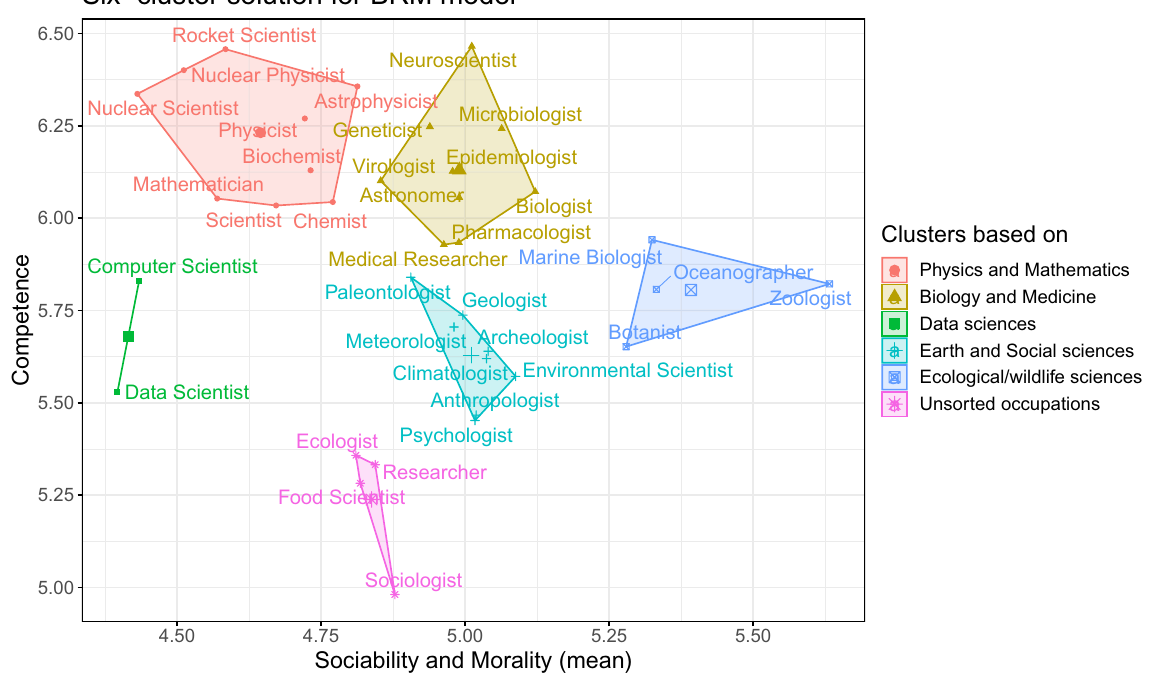
Figure 1. Six clusters of scientific occupations based on the ratings of competence, sociability, and morality. For the 2D representation, we collapsed sociability and morality because many models consider them subdimensions of a higher-order factor (named warmth 13 or communion 19 ). Lines represent cluster borders, with each cluster having its own color and symbol. Cluster centroids are represented with a large symbol in the cluster